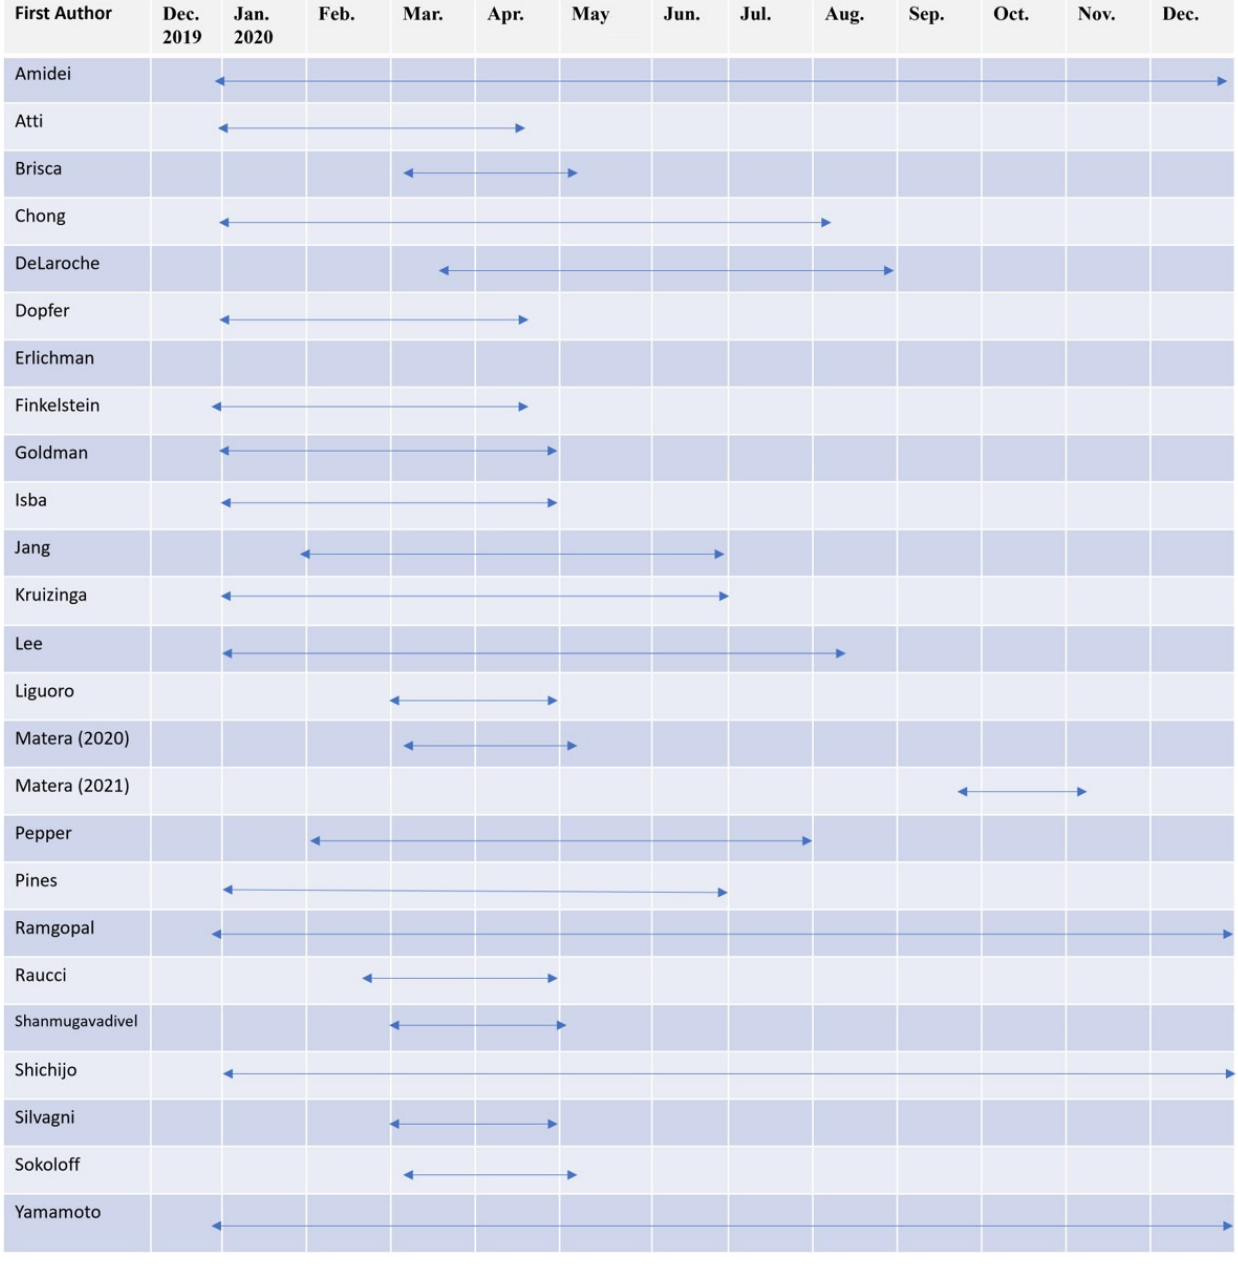
Figure 3. Timeline of study periods of the included articles.